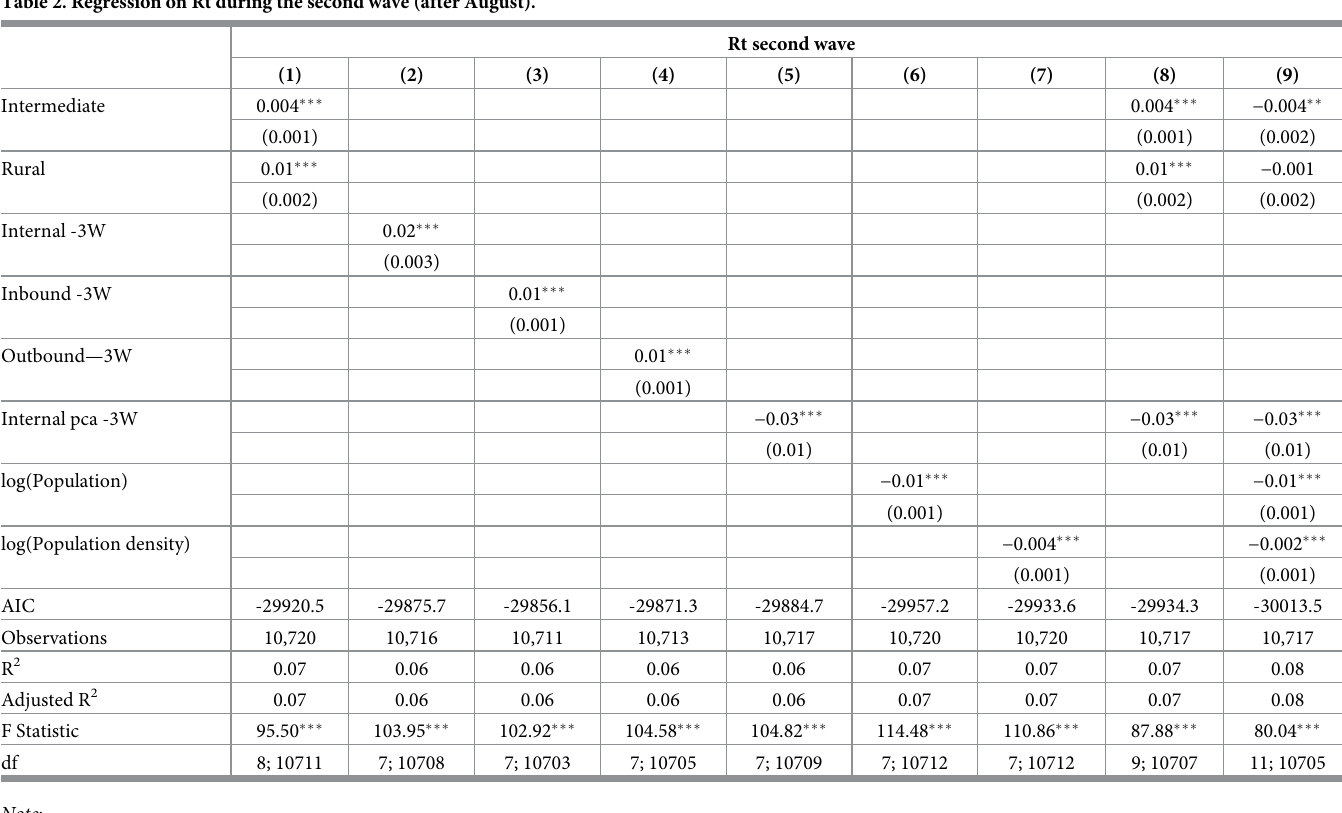
Table 2. Regression on Rt during the second wave (after